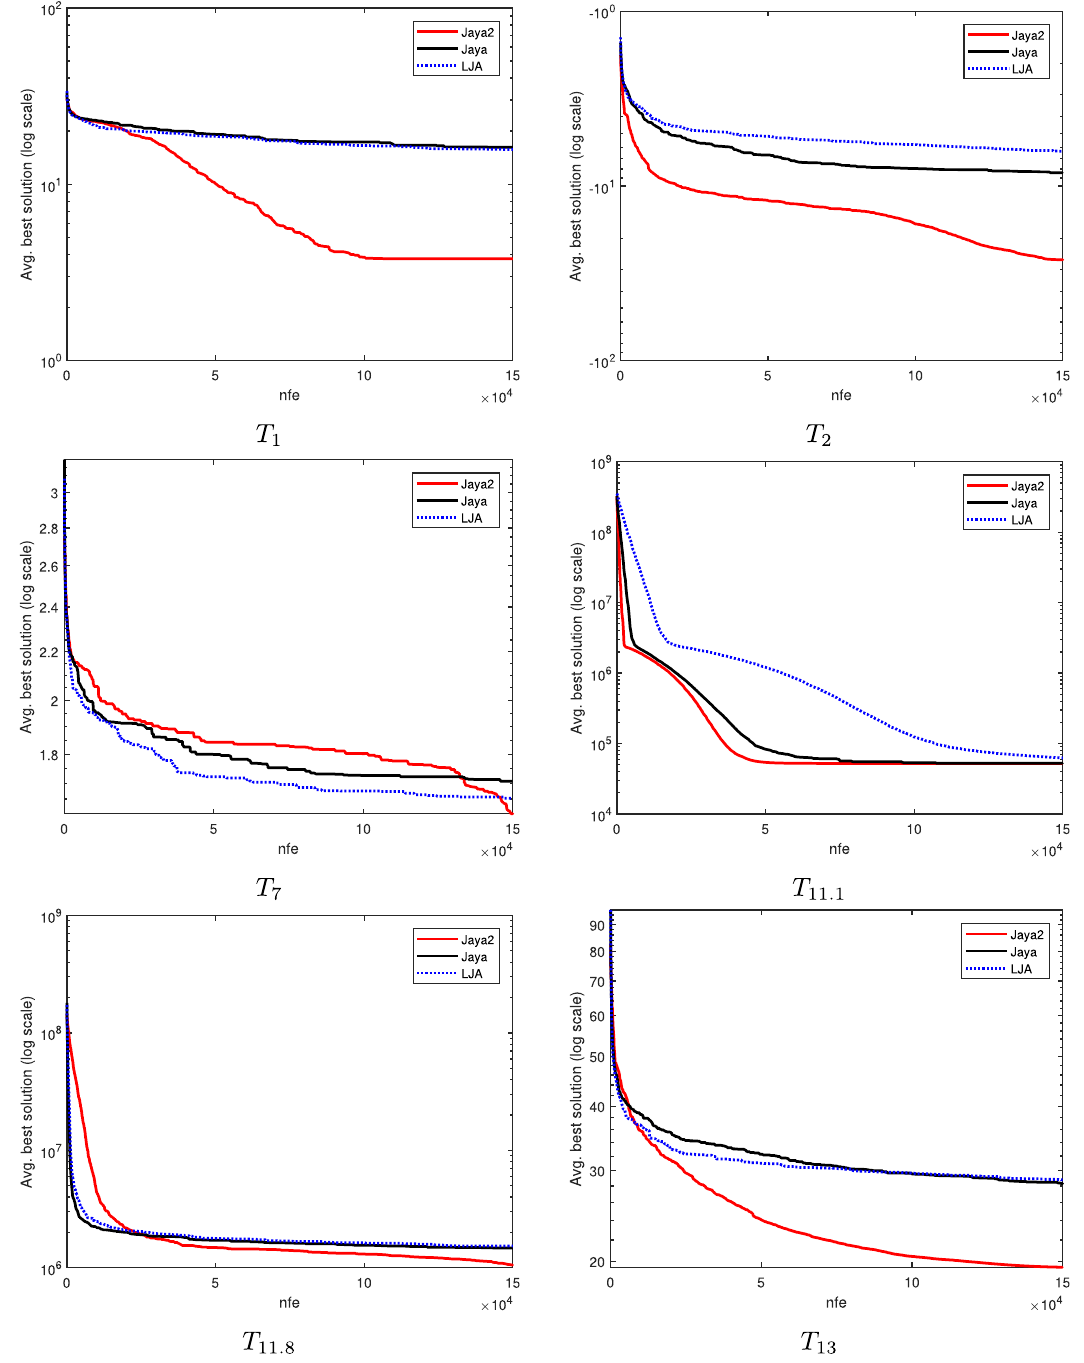
Figure 6: Best function value curves ( averaged across 25 runs ) of Jaya2, Jaya, and LJA for selected CEC 2011 real - world